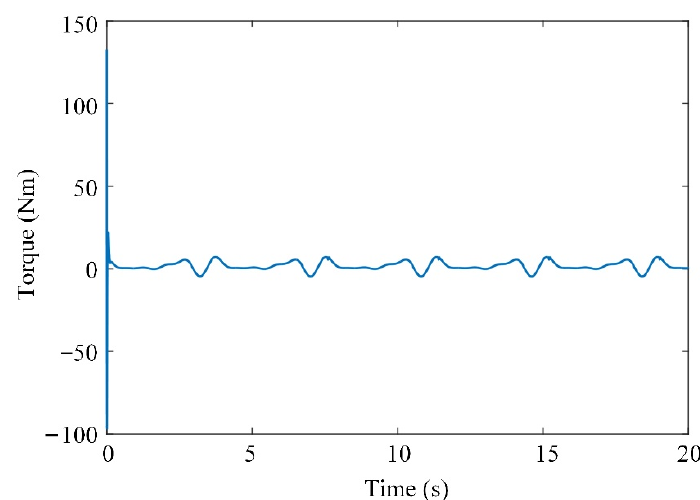
Figure 10. Generated torque.